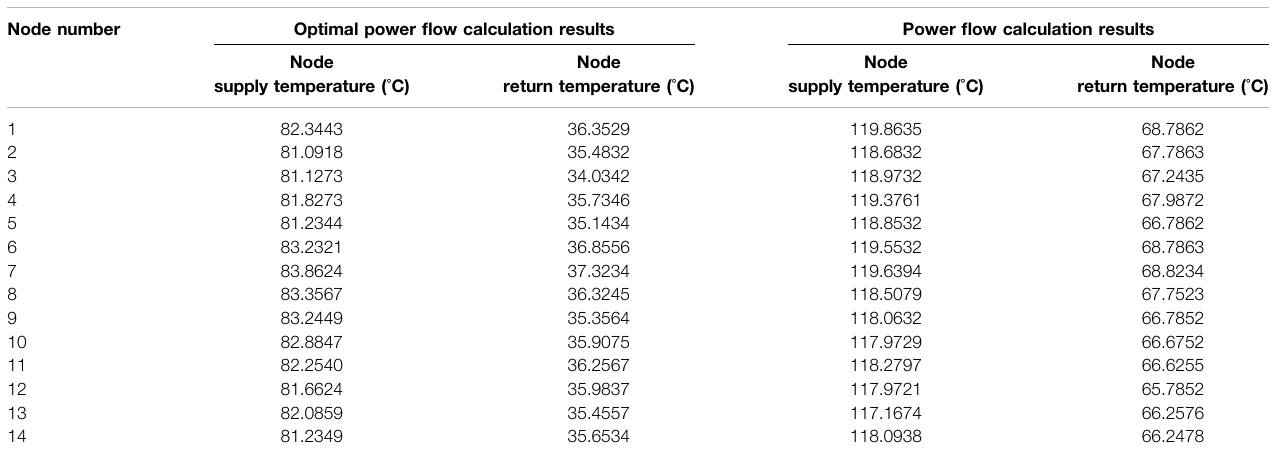
TABLE 6 | Temperature comparison of heating network